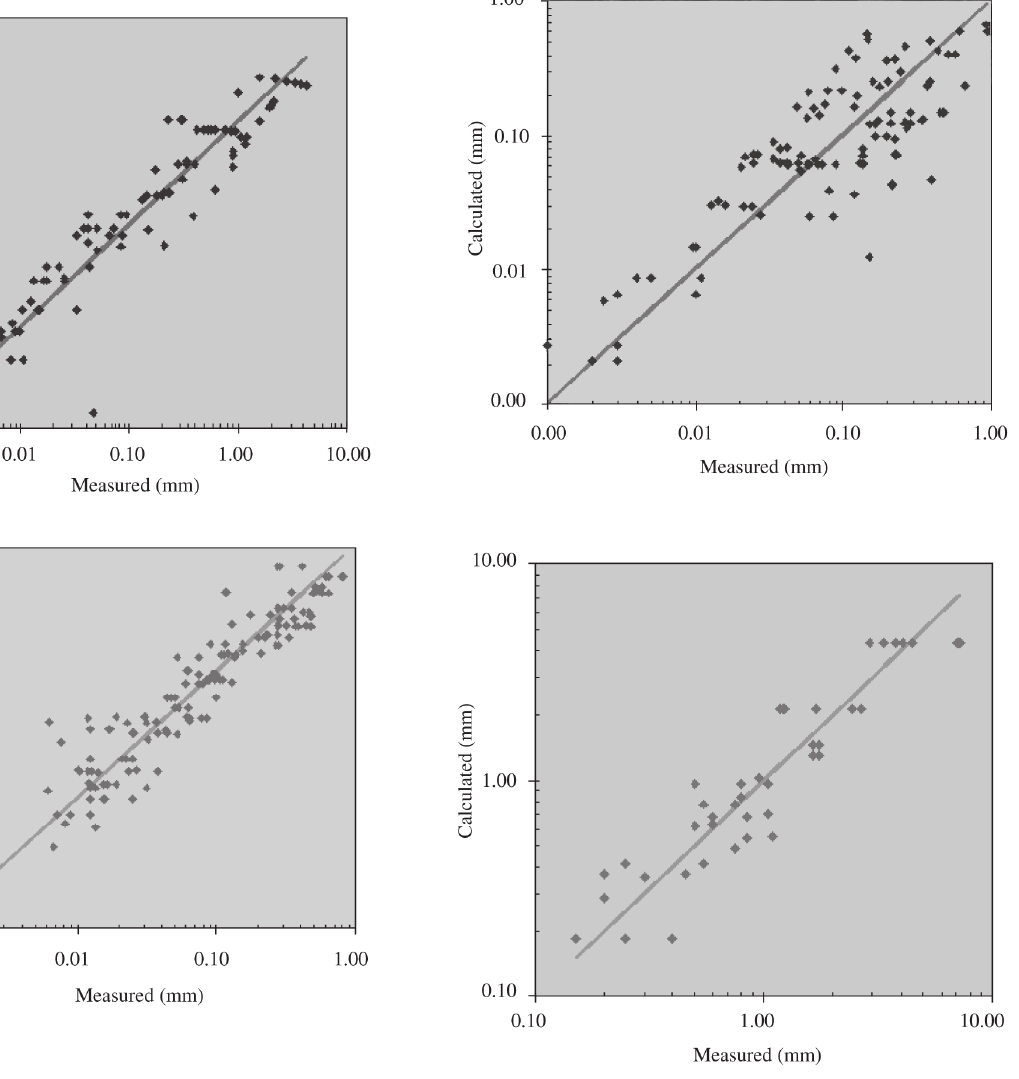
Figure 11. Examples of Correlations of Corrosion Data for Several Alloy/Corrosion Mechanisms